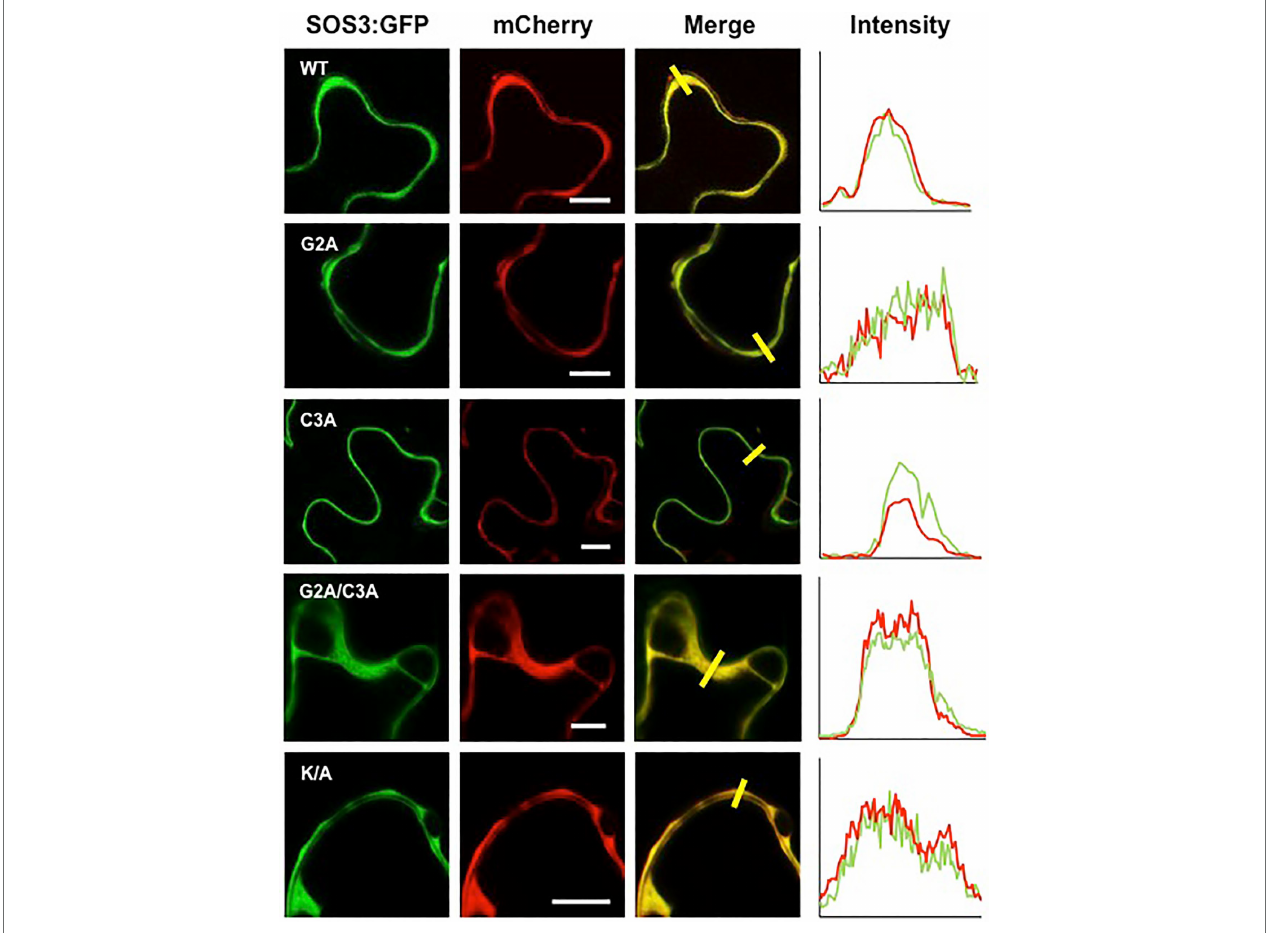
FIGURE 7 | Cytoplasmic localization of SOS3 mutant proteins. Wild-type SOS3 and mutant proteins G2A, C3A, G2A/C3A, and K/A, all fused with GFP, were transiently co-expressed in N. benthamiana with the nucleo-cytoplasmic marker mCherry. The plot on the right shows the fluorescence intensity in the green and red channels along transects depicted as yellow bars in the micrographs with green and red channels merged. The coincidence of maxima in green and red traces indicates protein co-localization. White bars in middle column = 10 μ